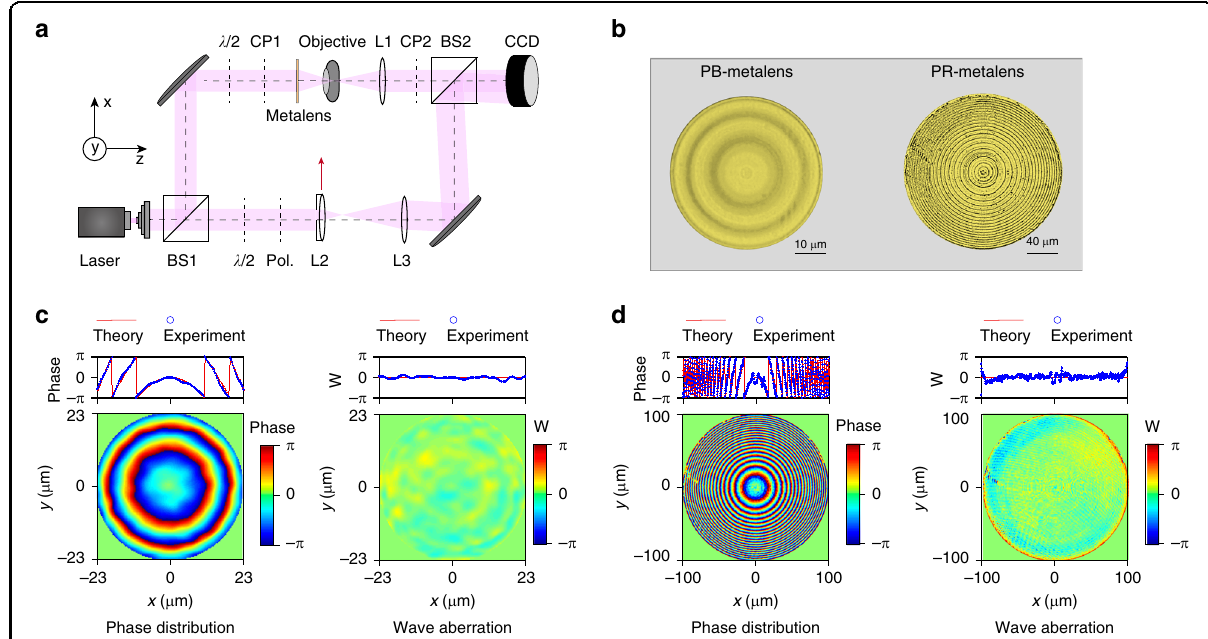
Fig. 2 Experimental setup and measured results of a PB-metalens and a PR-metalens. a Schematic graph of the experimental setup: BS1, BS2, beam splitters; L1, L2 and L3, lenses. L2 in the reference optical path can be moved to change the direction of the reference beam. b Photograph of a PB-metalens and a PR-metalens. c Measured phase distribution and wave aberration (W) of the PB-metalens. d Measured phase distribution and wave aberration (W) of the